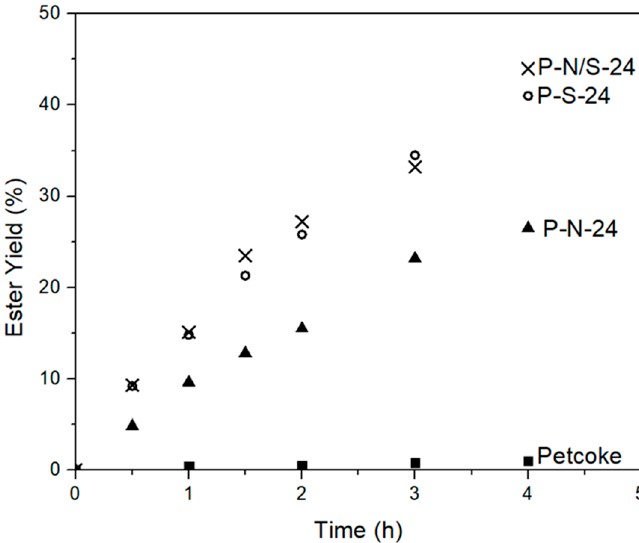
Figure 7. The yield of caprylic acid methyl ester from esterification reactions with petcoke before and after various acid treatments. Reaction conditions: 5 mL (~4.5 g) octanoic acid, 25 mL methanol